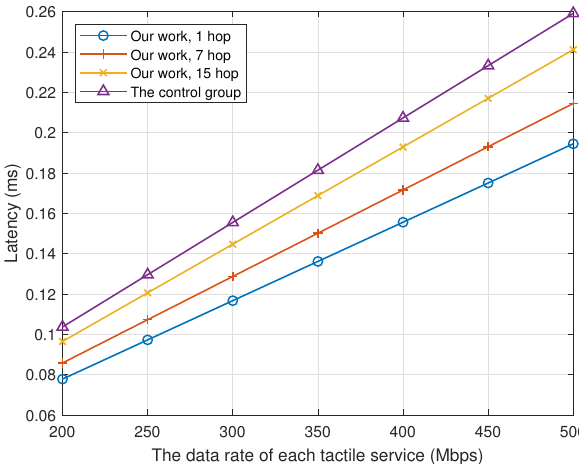
Figure 7. The latency with different tactile